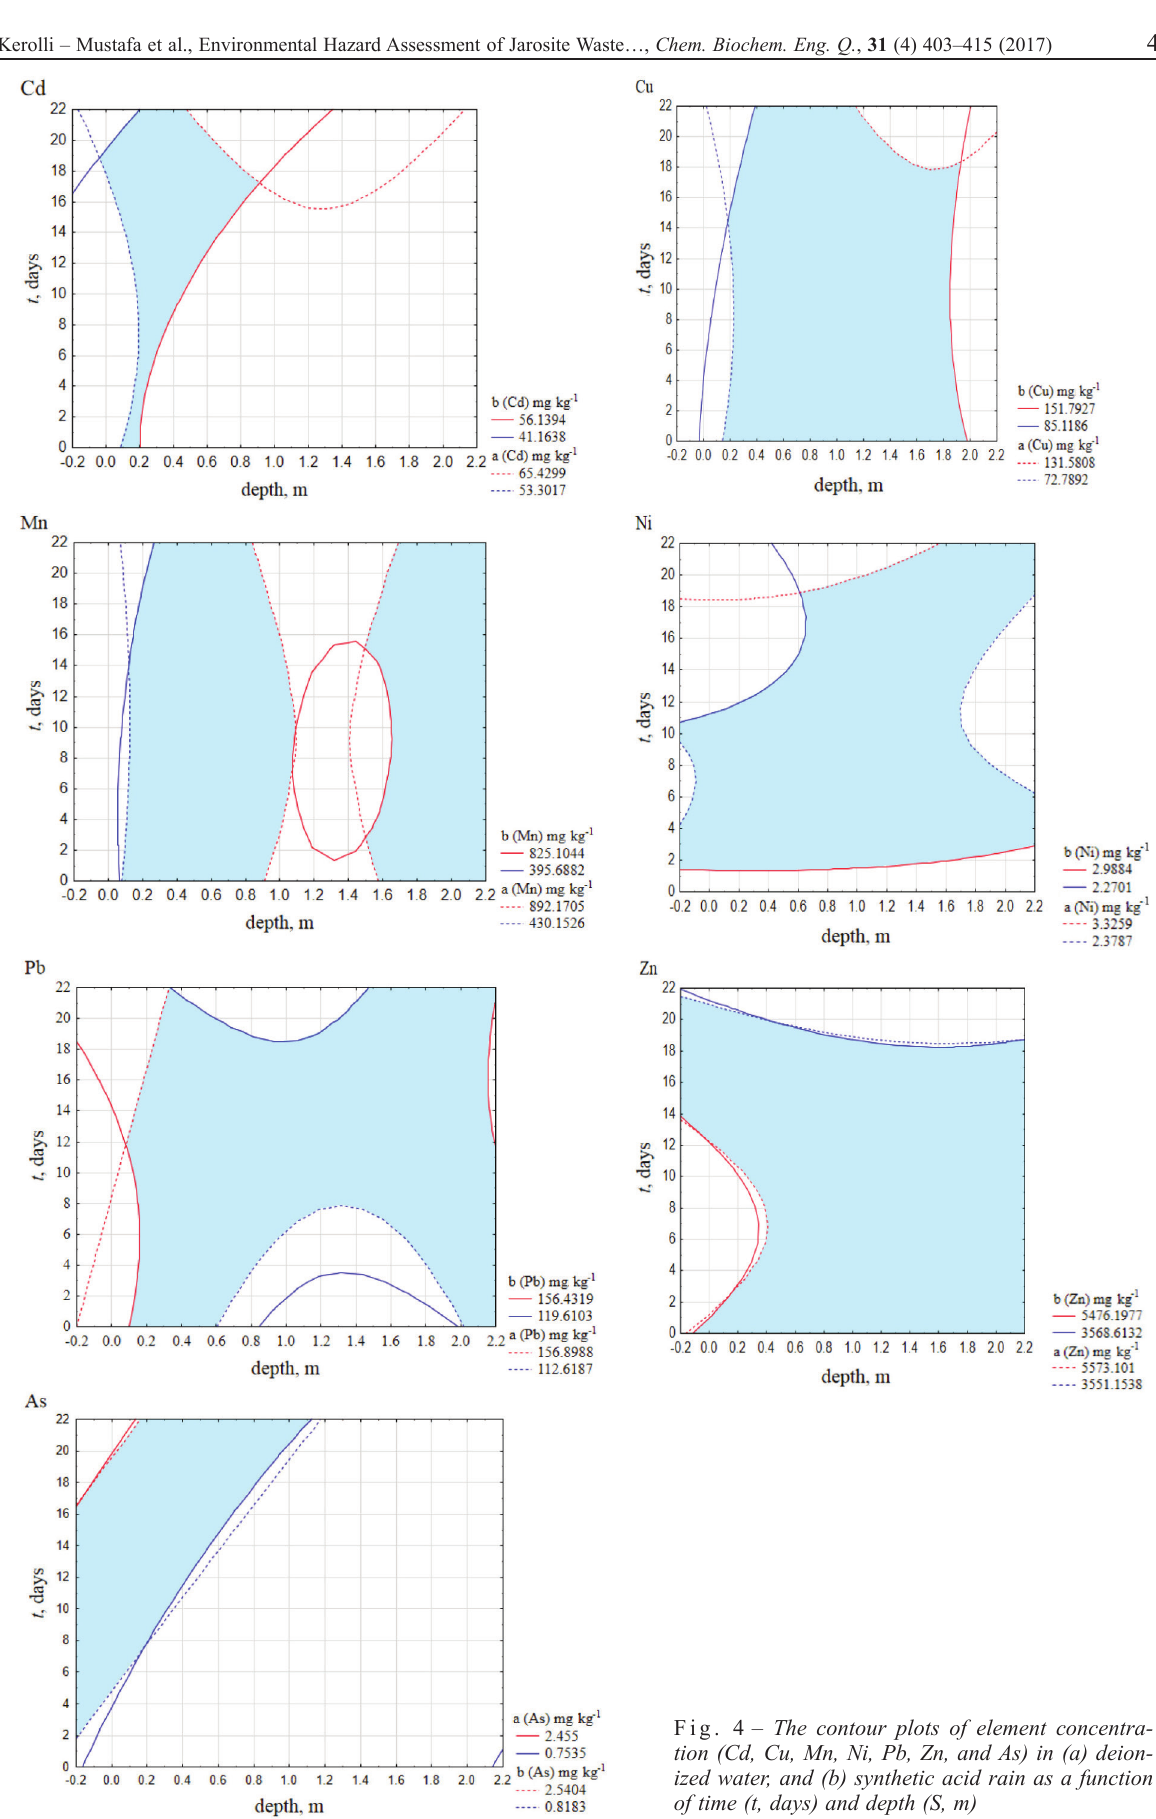
Fig. 4 – The contour plots of element concentra- tion (Cd, Cu, Mn, Ni, Pb, Zn, and As) in (a) deion- ized water, and (b) synthetic acid rain as a function of time (t, days) and depth (S,